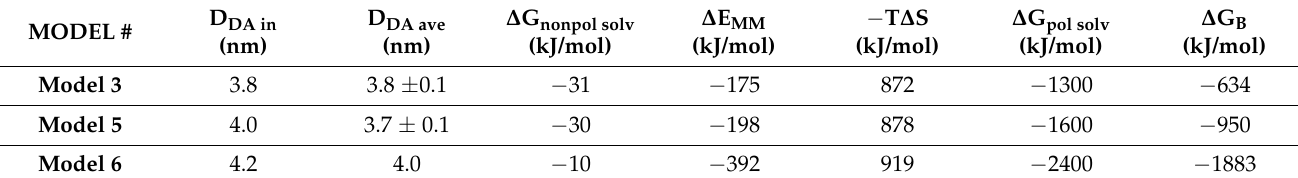
Figure 4. Graphical representation of: ( A ) model for miR-155. ( B ) Collective representation of the ten best models for the HSA/miR-155 complex. Regarding HSA, domain I is colored in yellow, domain II in green and domain III in orange; Trp214 being shown as blue spheres. The three possible binding sites of HSA for miR-155 are indicated by α , β and γ . Table 1. Some properties of the three best models for the HSA/miR-155 complex. D DA in is the initial distance between the 5 (cid:48) end of miR-155 and the aromatic ring center of the lateral chain of Trp214, D DA ave is the average over the MD simulations. ∆ G B is the binding free energy calculated from ∆ G B = ∆ complex − ( ∆ G receptor + ∆ G ligand ), from the various terms: ∆ G nonpol solv is the nonpolar contribution to the solvation term, ∆ E MM , the internal energy, − T ∆ S MM , the entropic term, and finally the ∆ G pol solv is the electrostatic contribution to the solvation